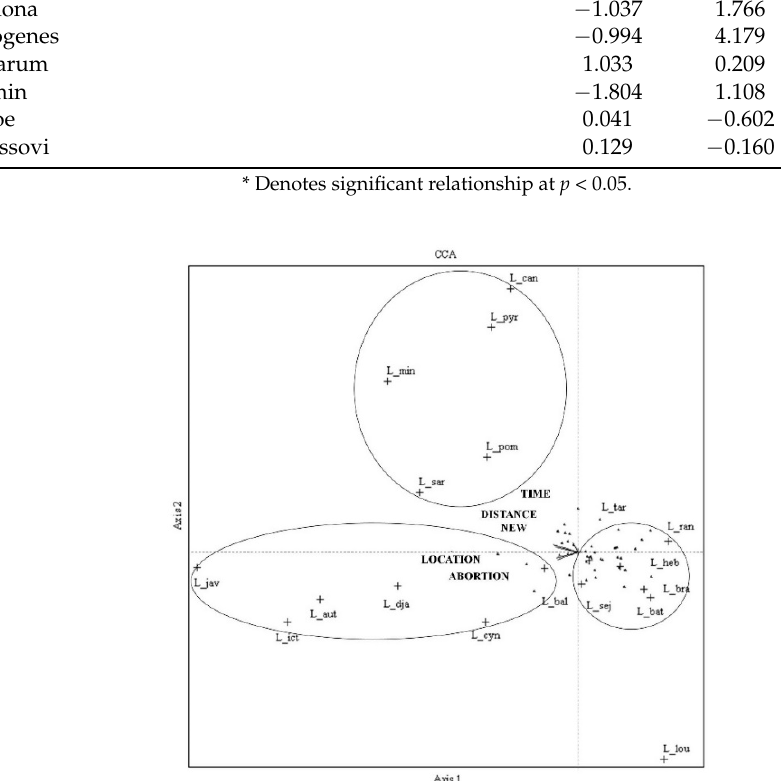
Figure 3. Relationships of 18 seroprevalence and herd variables revealed of domesticated cattle by Correlative Coherence Analysis (CCA) in the Salakphra Wildlife Sanctuary, TIME = Number of years that livestock were kept in the farm (years), DISTANCE = Raising distance (km/day), NEW = Introduced of new animal into herd, LOCATION = Raising in the same route with other herds, ABORTION = Abortion history, L_aut = Autumnalis, L_bal = Ballum, L_bat = Bataviae, L_bra = Bratislava, L_can = Canicola, L_cyn = Cynopteri, L_dja = Djasiman, L_heb = Hebdomadis, L_ict = Icterohaemorrhagica, L_jav = Javanica, L_lou = Louisiana, L_min = Mini, L_pom = Pomona, L_pyr = Pyrogenes, L_ran = Ranarum, L_sar = Sarmin, L_sej = Sejroe.